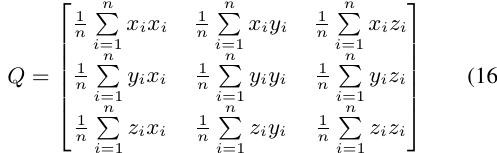
Figure 5. Handheld laser scanner